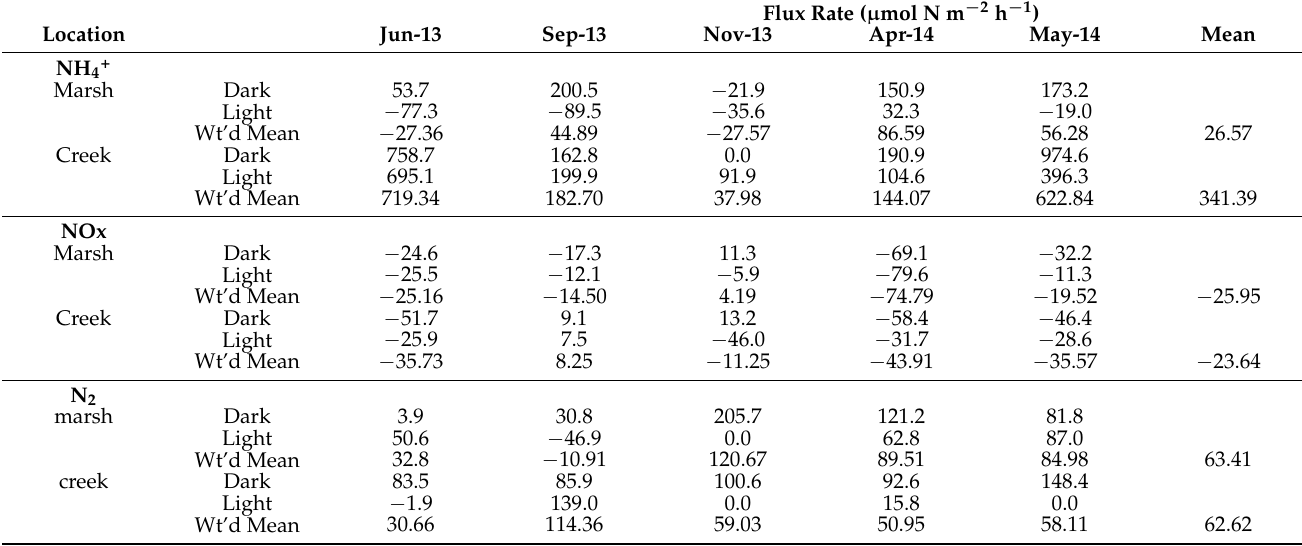
Table A2. Sediment flux measurements, showing means for light and dark incubations and the weighted daily mean (Wt’d Mean) on five dates. Negative values represent import into the sediment; positive values represent release to the overlying